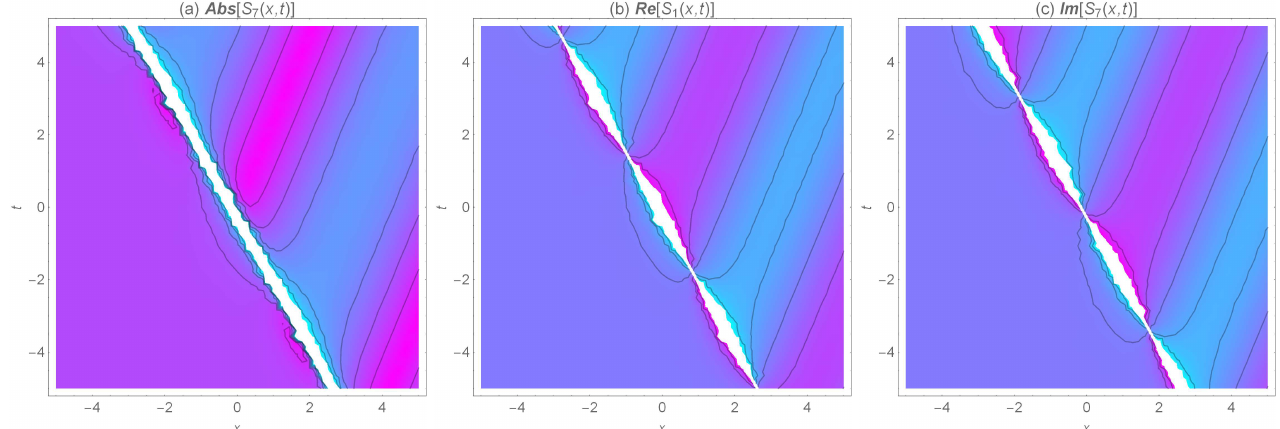
Figure 8. The 2D density of the wave surfaces for the absolute, real, and imaginary values of the singular kink-like soliton solution for b = 0.9, c = − 0.3, s = 1.5, k = 1, ϑ 0 = 0.2, ε 1 = 1, ε 2 = 1, ε 3 = 1.2, Ω =